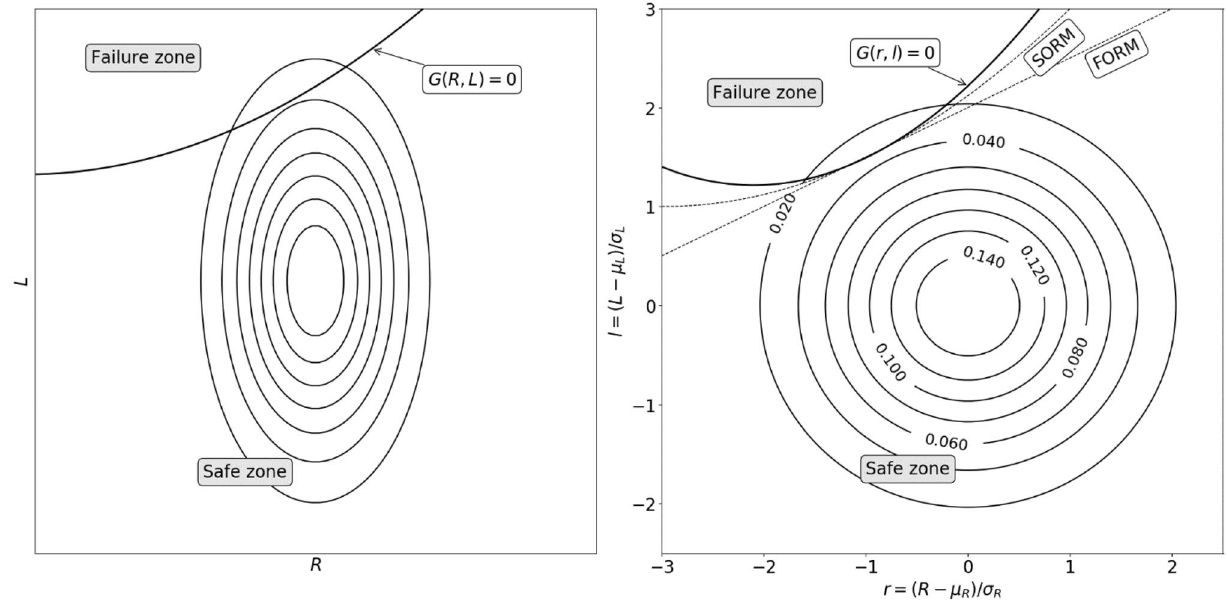
Fig. 2 FORM illustrative Scheme: original and standard normal